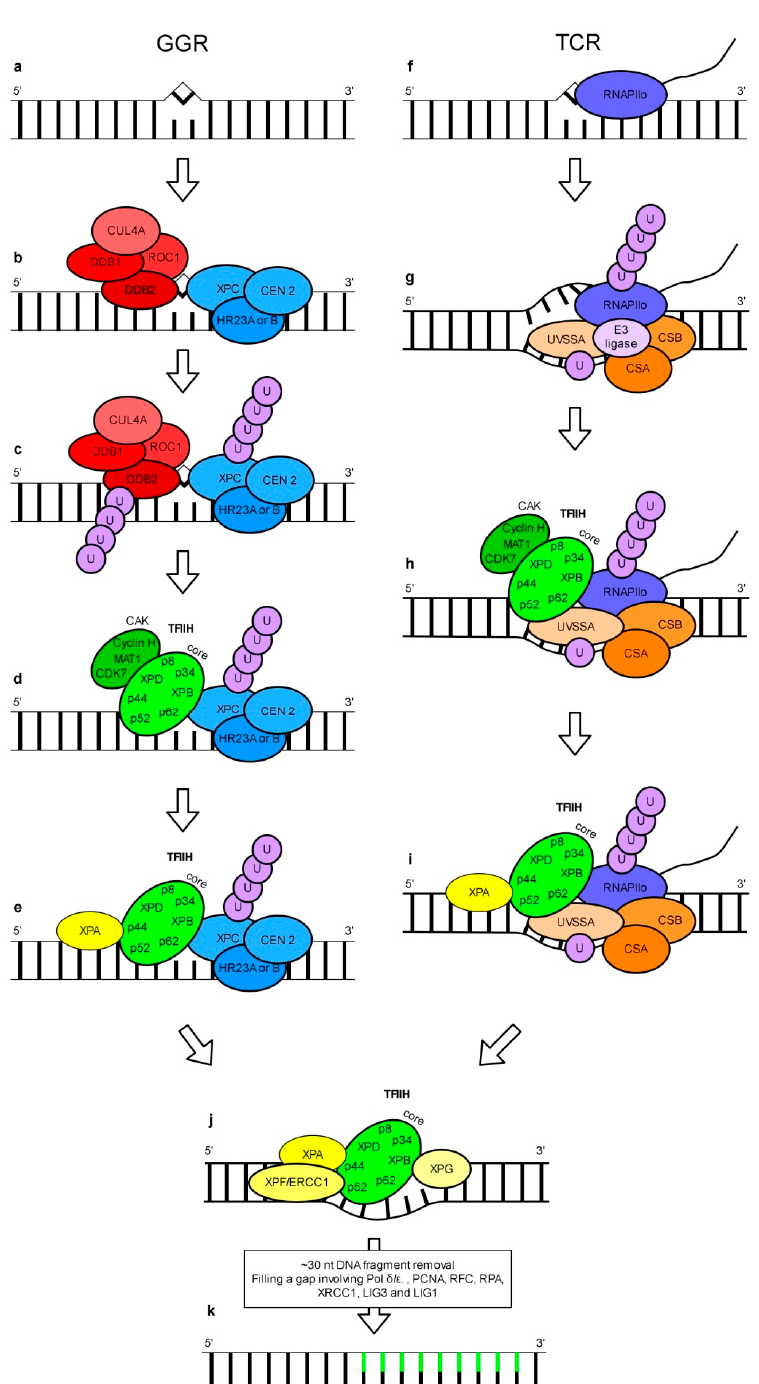
Figure 2. A simplified mechanism of the GGR (global genome repair) and TCR (transcription-coupled repair) subpathways of NER based on a mammalian model. Detection and processing of a DNA lesion in GGR ( a – e ). Bulky DNA damage (e.g., 6-4 PP) changes the DNA structure ( a ). Such a lesion is recognized by the XPC-HR23-CEN2 ( Xeroderma pigmentosum , complementation group C-UV excision repair protein RAD23- centrin 2) complex. The DDB1-DDB2-CUL4-ROC1 (damaged DNA-binding-cullin 4A-homeobox-leucine zipper protein ROC1) complex assists in the recognition of other lesions such as CPDs (cyclobutane pyrimidine dimers) ( b ). DDB2 and XPC are polyubiquitinated by E3 ligase activity of the UV-DDB complex composed of DDB1 and DDB2 proteins ( c ). The TFIIH (transcription factor II H) complex consisting of a kinase subcomplex—CAK ( CDK (cyclin-dependent kinase) - activating kinase) and a core complex is recruited to the site of the lesion while the